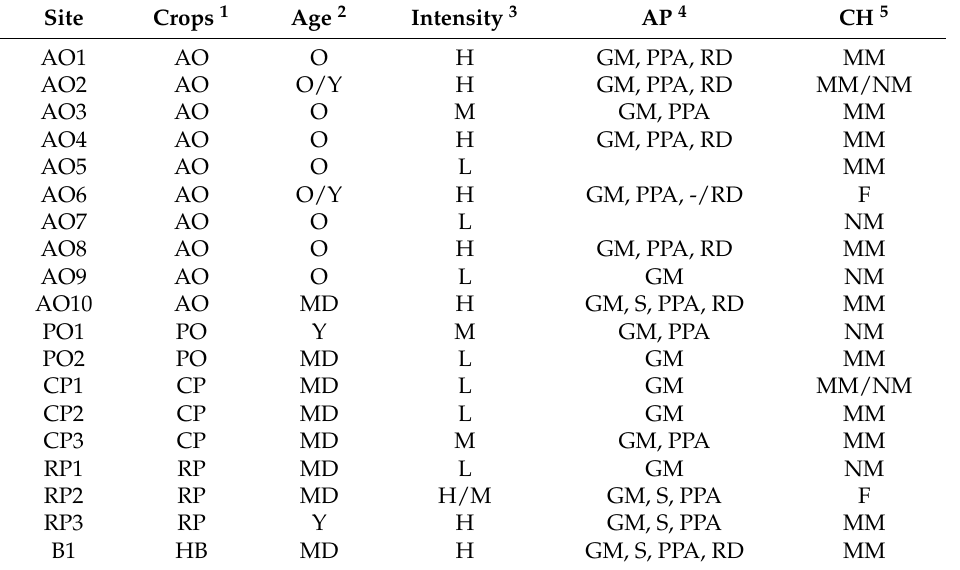
Table A1. Characteristics of study sites in orchards and plantations; site numbers as in Figure 1.